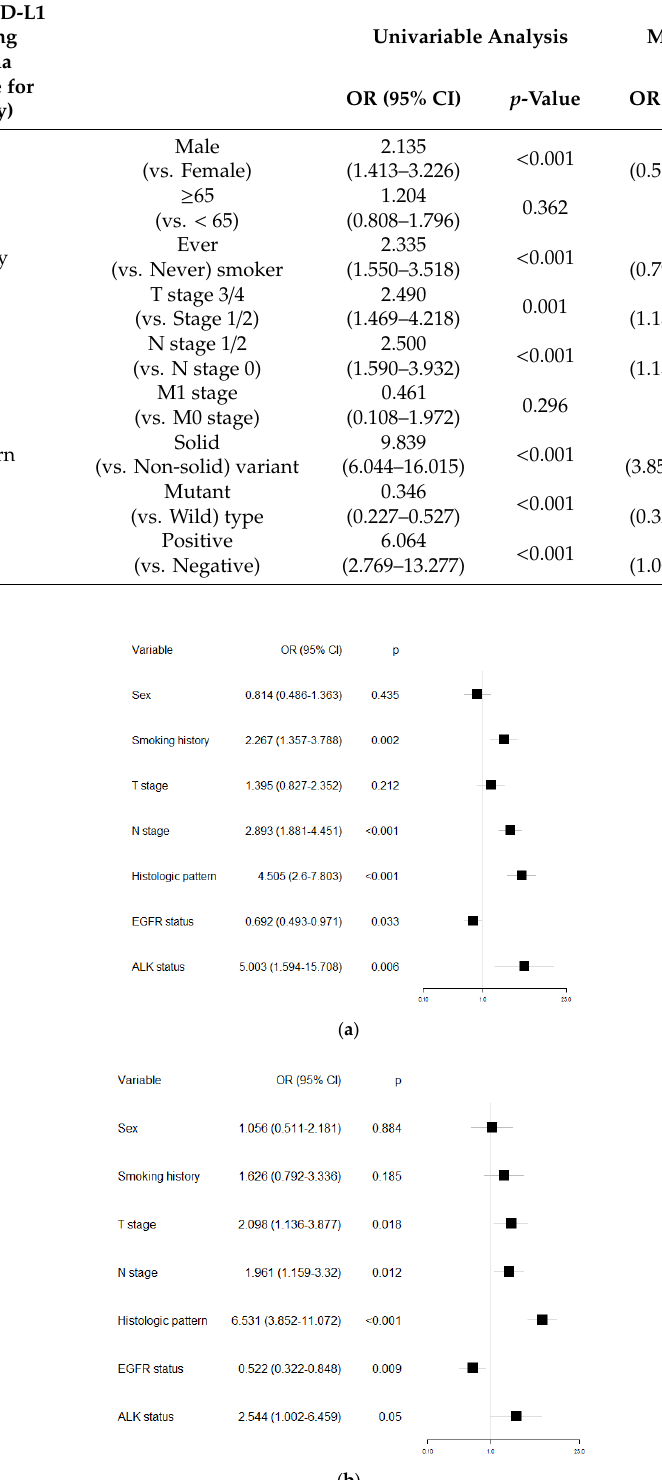
Table 6. Multivariate logistic regression analysis of clinicopathological features for PD-L1 expression in lung adenocarcinoma (50% cuto ff value for PD-L1 positivity).